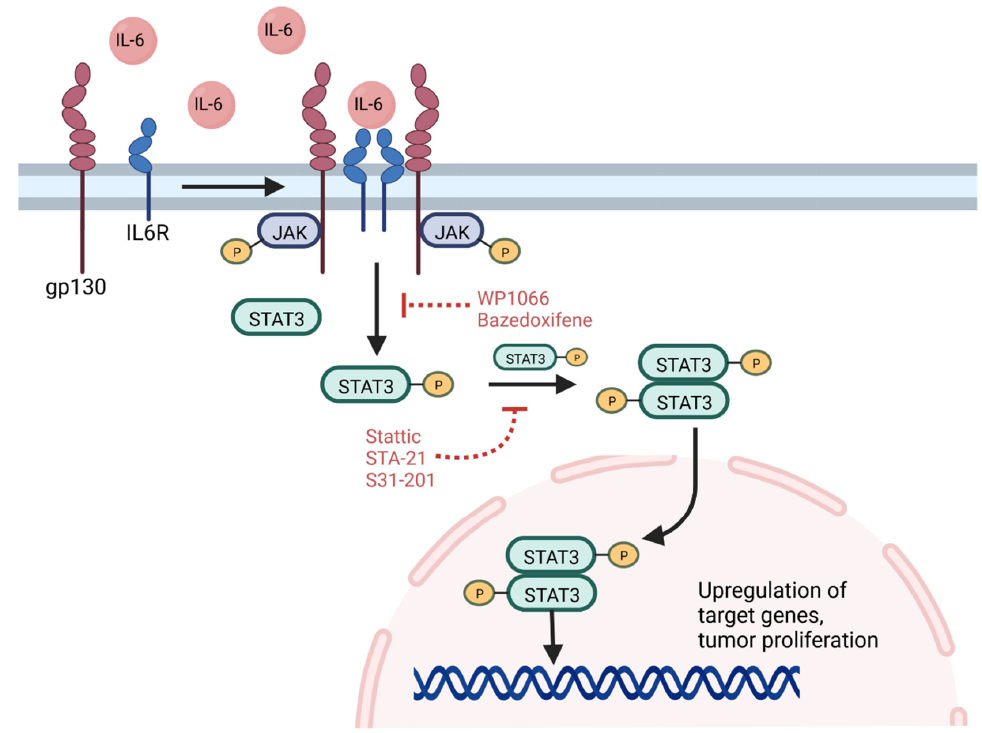
Figure 2. STAT3 signaling pathway. The IL-6 cytokine triggers dimerization and activation of the IL6 receptor with its gp130 subunit. JAK phosphorylation in turn results in STAT3 phosphorylation, which dimerizes and translocates to the nucleus to upregulate target genes associated with stemness and GSC survival. Inhibition of the STAT3 pathway can be achieved at several points, including targeting of receptor signaling using WP1066 or bazedoxifene and inhibition of STAT3 dimerization and signaling using Stattic, STA-21, or S31-201. GP130—glycoprotein 130, IL6R—IL6 receptor, P—phosphorylation, STAT3—signal transducer and activator of transcription